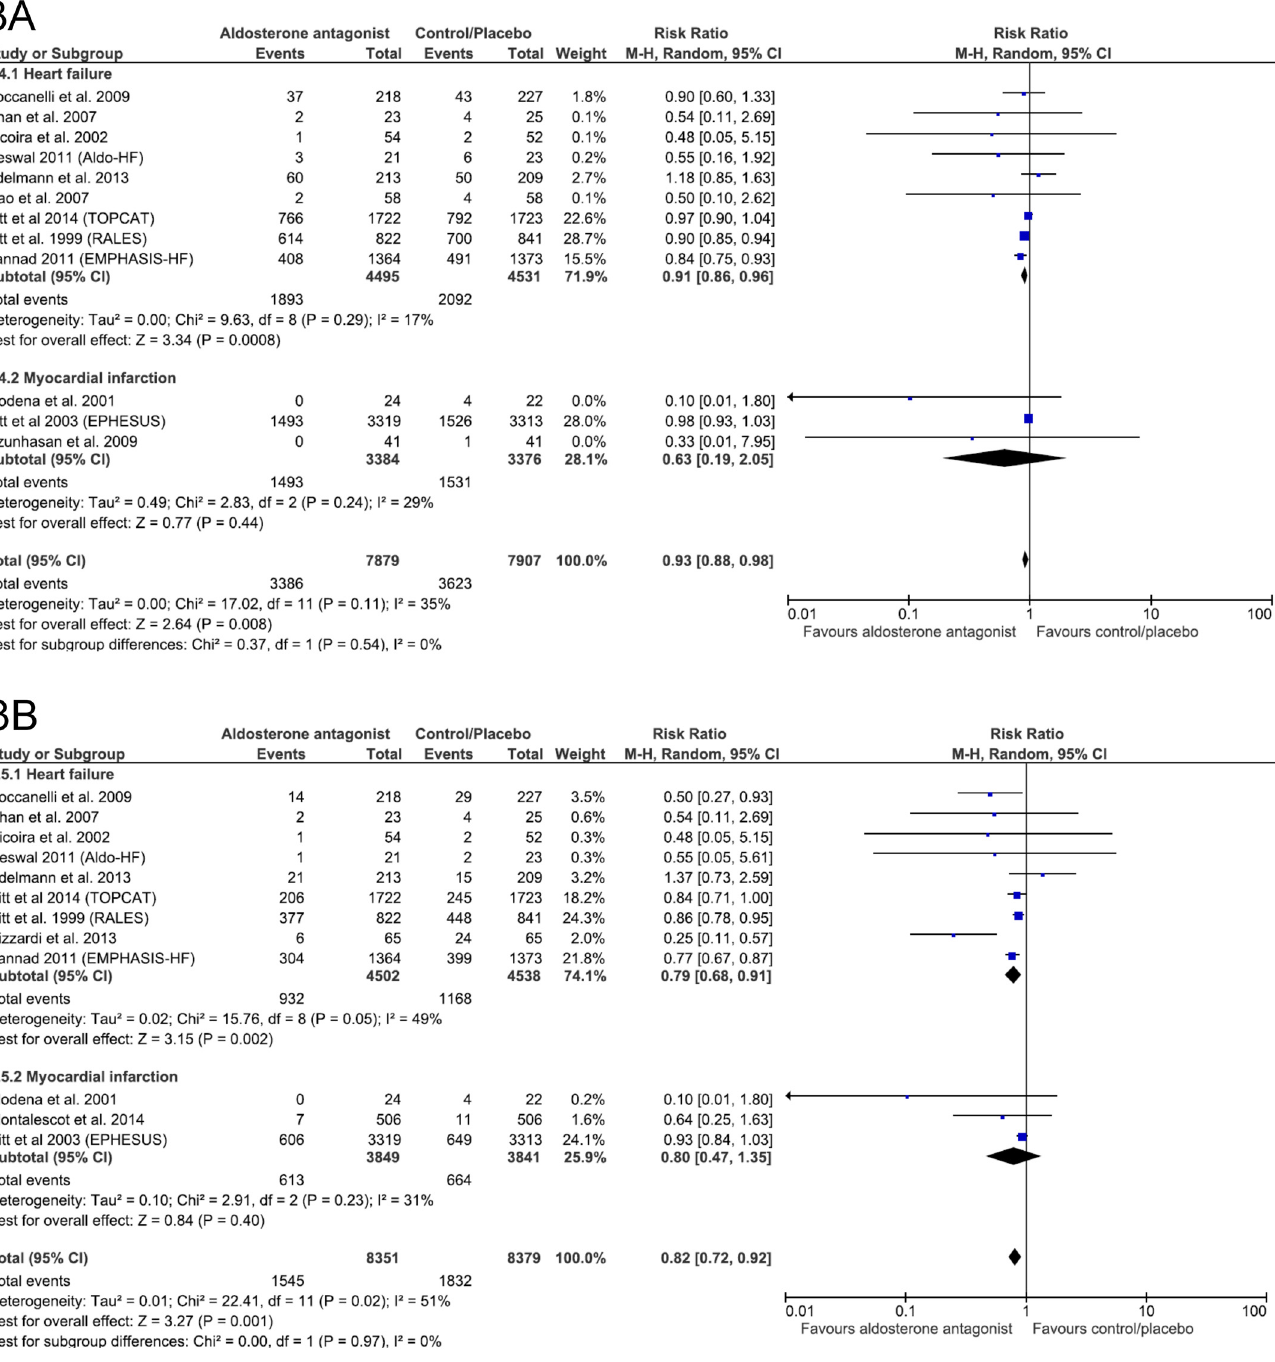
Fig 3. Efficacy of aldosterone antagonist compared to control for the prevention of (A) All-cause hospitalization and (B) Cardiovascular hospitalization in patients with heart failure or myocardial infarction.